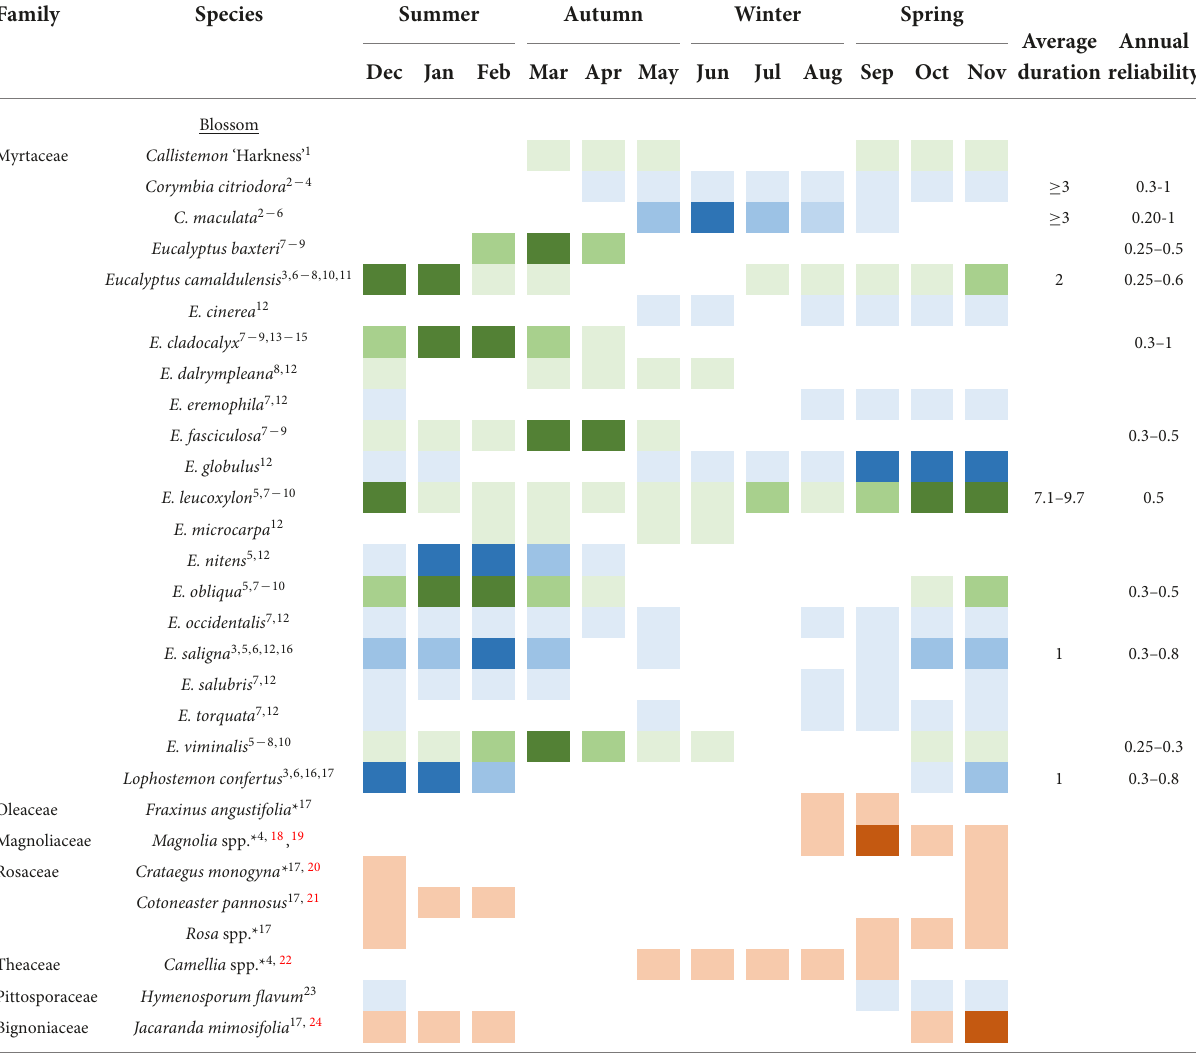
F. platypoda , F. macrophylla , and F. microcarpa ( Table 2